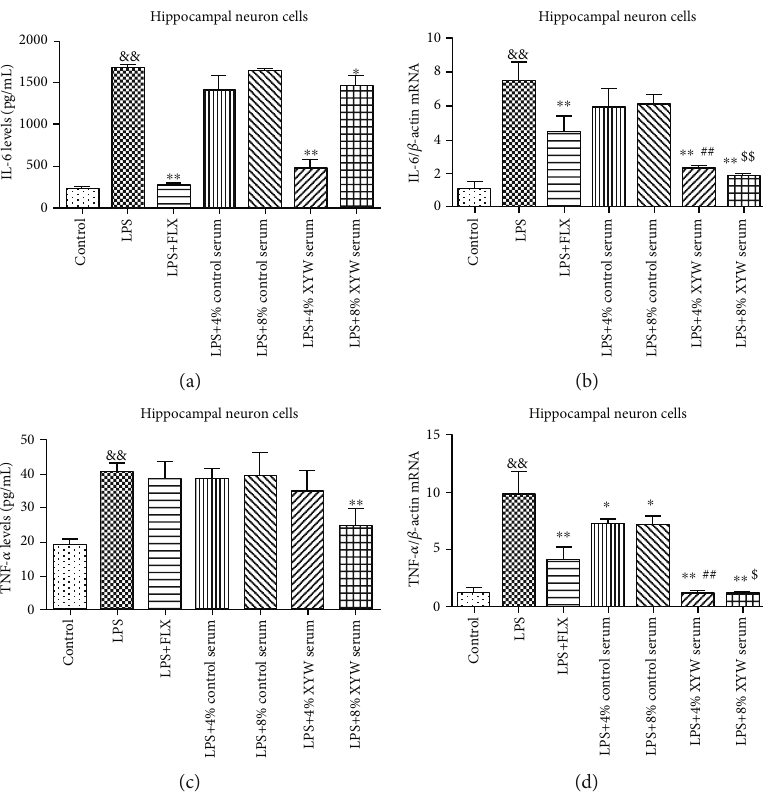
Figure 2: Xiaoyao Pill serum ( fi nal concentration of 4% and 8%) reduced the expression of IL-6 and TNF- α in hippocampal neuronal cells. The protein levels of IL-6 in supernatant (a). The relative mRNA expression of IL-6 in cell lysate (b). The protein levels of TNF- α in supernatant (c). The relative mRNA expression of TNF- α in cell lysate (d). The results were expressed as the mean ± SD ( n = 4 ‐ 5 ). && p < 0 : 01 compared to the control group. ∗ p < 0 : 05 and ∗∗ p < 0 : 01 compared to the LPS group. ## p < 0 : 01 compared to the LPS+4% control serum group. $$ p < 0 : 01 compared to the LPS+8% control serum